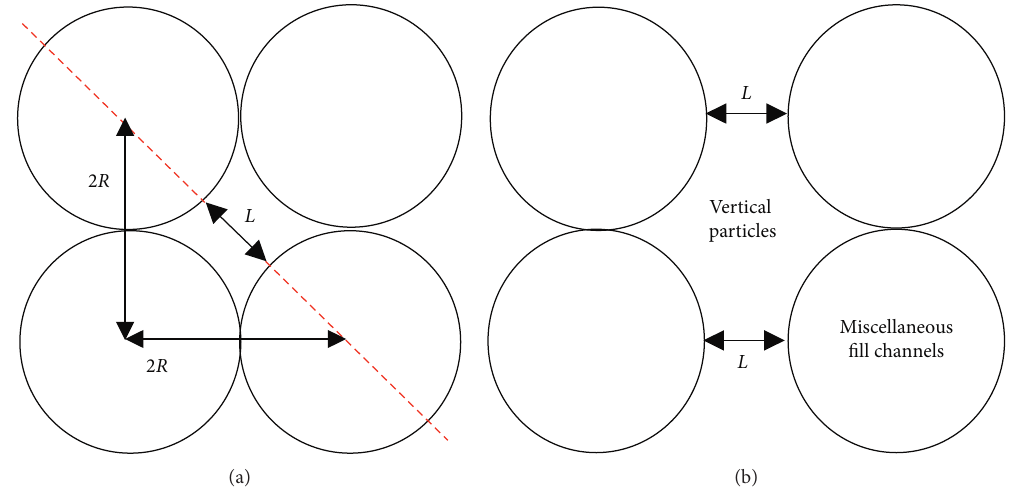
Figure 2: Channels formed by miscellaneous fill particles. (a) Top view. (b) Profile.